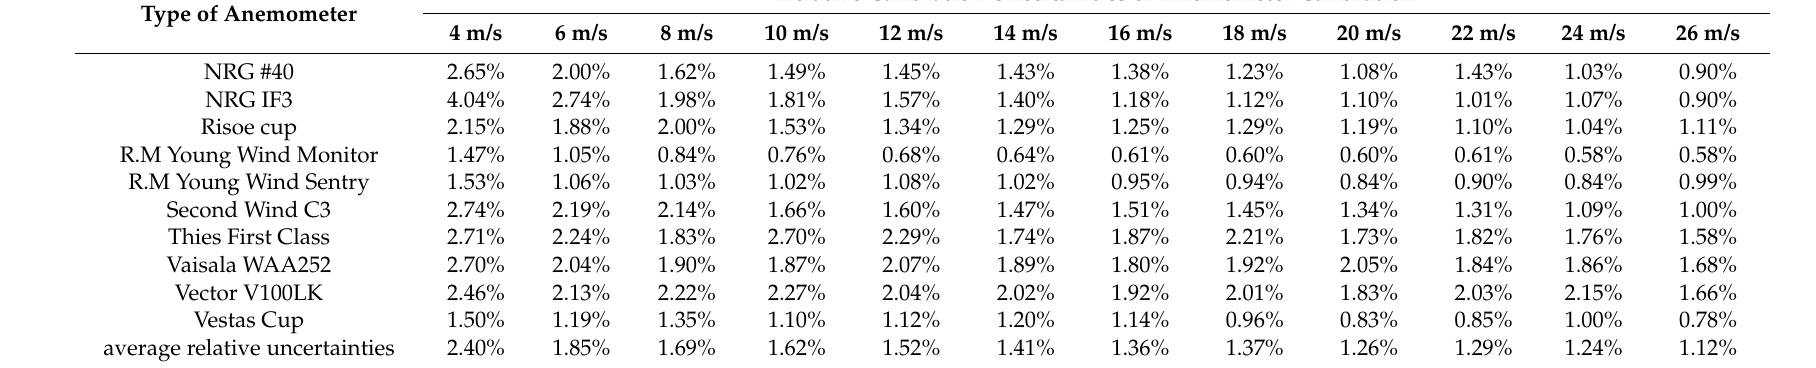
Table 3. Relative calibration uncertainty of ten commonly used